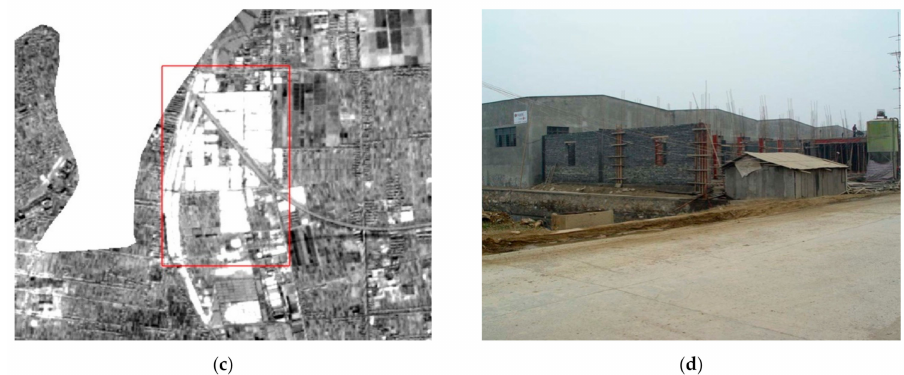
Figure 4. Example of PCA-enhanced land use change information from cropland and water to urban land in the third principal component (PC3), 2003–2006. ( a ) RGB composition image of SPOT-5 (2003); ( b ) (RGB) composition image of SPOT-5 (2006); ( c ) the third principal component; ( d ) field survey photo (2006).